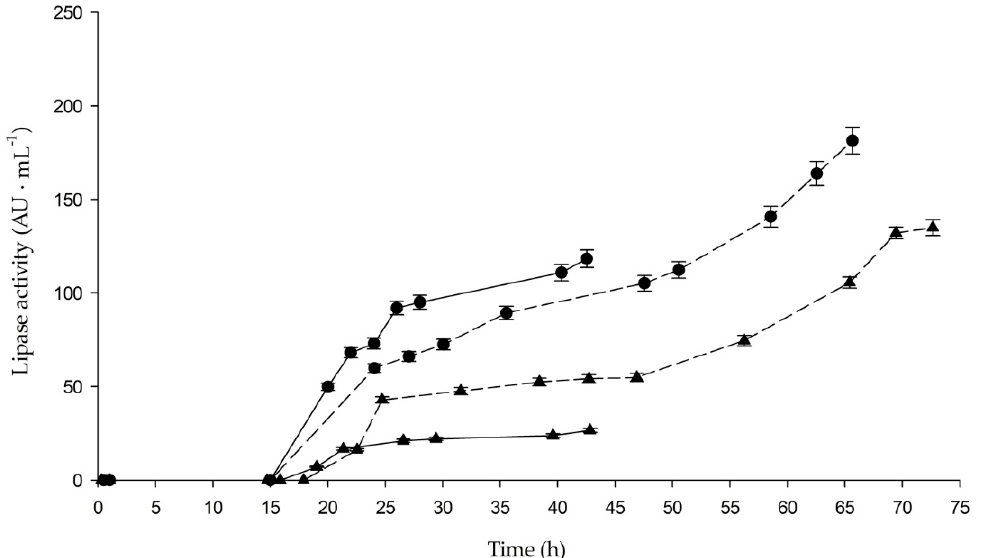
Figure 1. Lipase activity evolution in MLFB (methanol limiting fed-batch) cultures of proROL-strain and rROL-strain at two pre-fixed specific growth rates, 0.015 and 0.045 h − 1 . pre-fixed µ of 0.015 h − 1 (discontinuous line) and 0.045 h − 1 (continuous line). proROL-strain ( (cid:8) ) and rROL strain ( (cid:78) ). rROL, recombinant Rhizopus oryzae lipase; proROL, prosequence